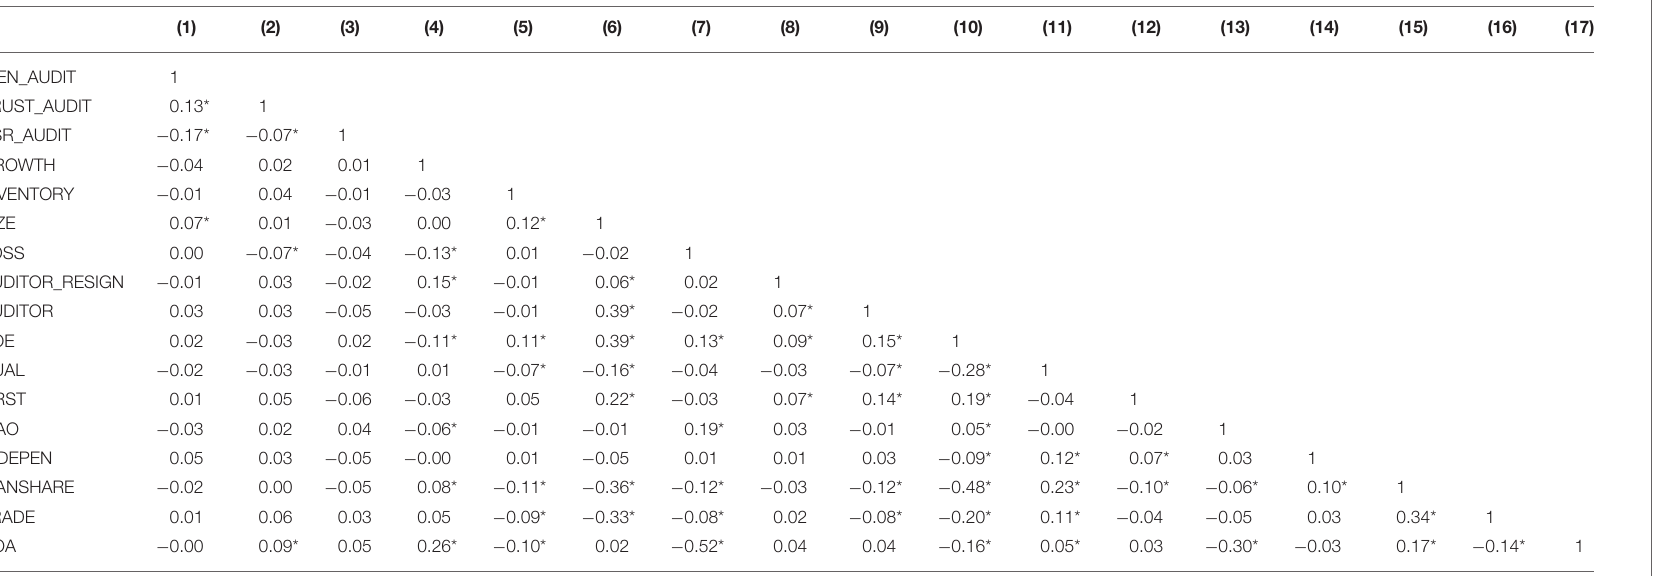
TABLE 7 | Correlation analysis: audit